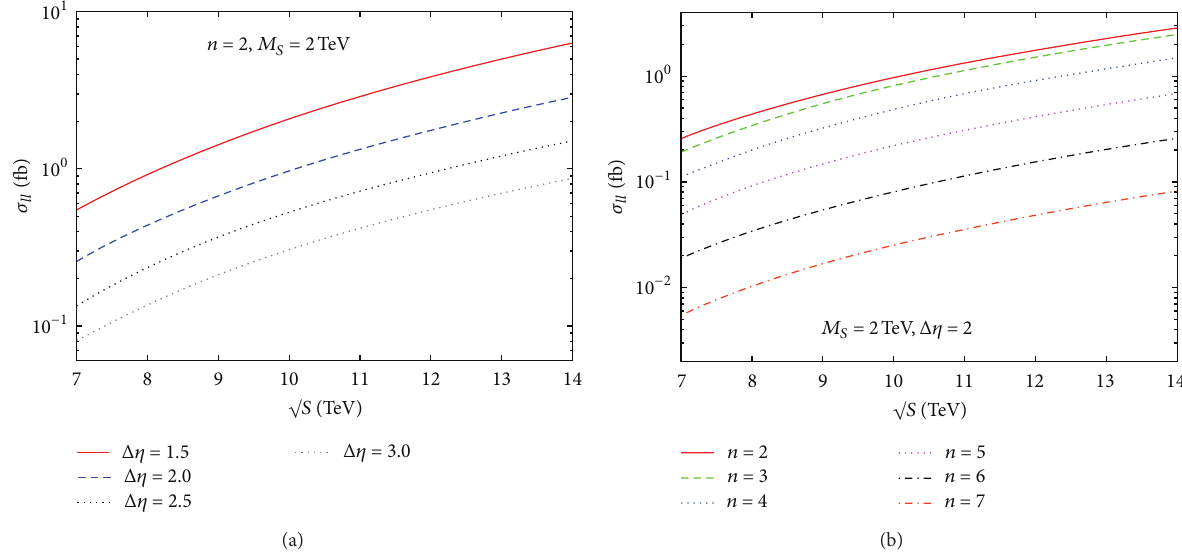
Figure 7: The total signal cross-section ( 𝑝𝑝 → 𝑋 + 𝑙𝑙 + 𝑌 ) in dilepton channel ( 𝜎 𝑙𝑙 ) as a function of LHC CM energy. In (a), we plot 𝜎 𝑙𝑙 for Δ𝜂 = 1.5, 2.0, 2.5, and 3.0 for 𝑛 = 2 and 𝑀 after applying the cut defined in